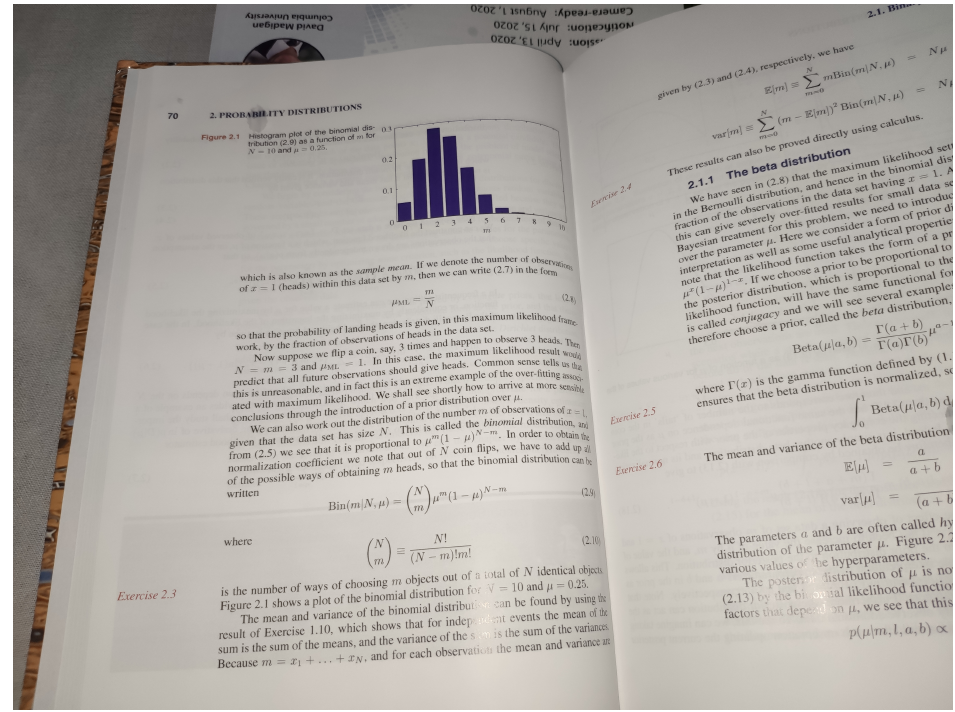
Figure 1. A Bar chart on real-world photography: tilted and in the middle of the text. The image is taken from a book [1]. Modern Chart Recognition methods do not cover real-world situations like this